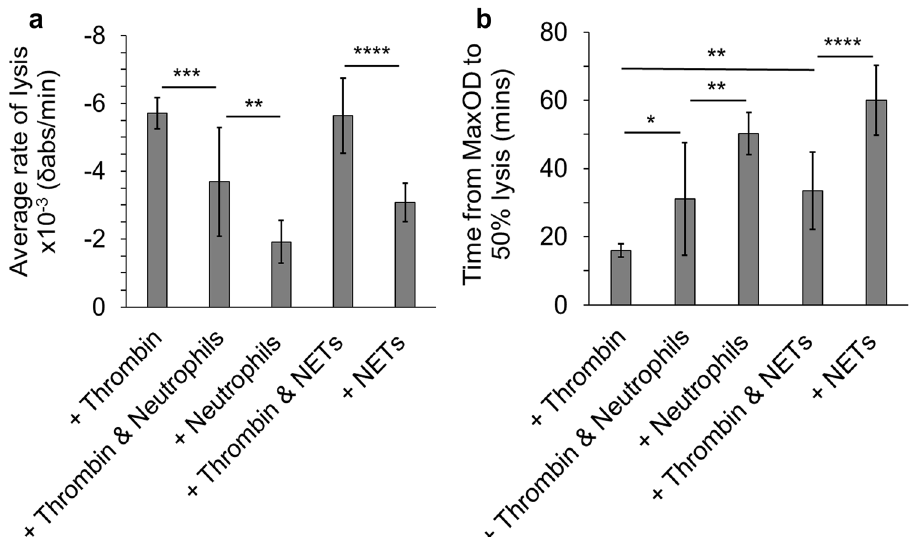
Figure 4. Lysis analysis of the effect of human neutrophils or human NETs on clot dissolution. Neutrophils (200,000 cells/100 µl) or NETs (generated from 200,000 cells/100 µl) were added to plasma. ( a ) Average rate of lysis and ( b ) time from MaxOD to 50% lysis were quantified. Other concentrations: plasma (diluted 1:6), CaCl 2 (3.33 mM) and thrombin (0.1 U/ml), Error bars represent ± SD of three technical replicates in triplicates. * P < 0.05, ** P < 0.01, *** P < 0.001, **** P <